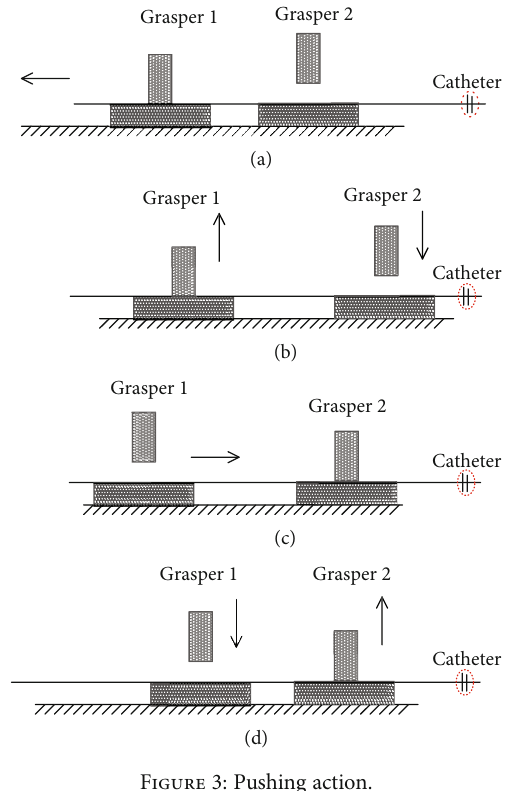
Figure 3: Pushing